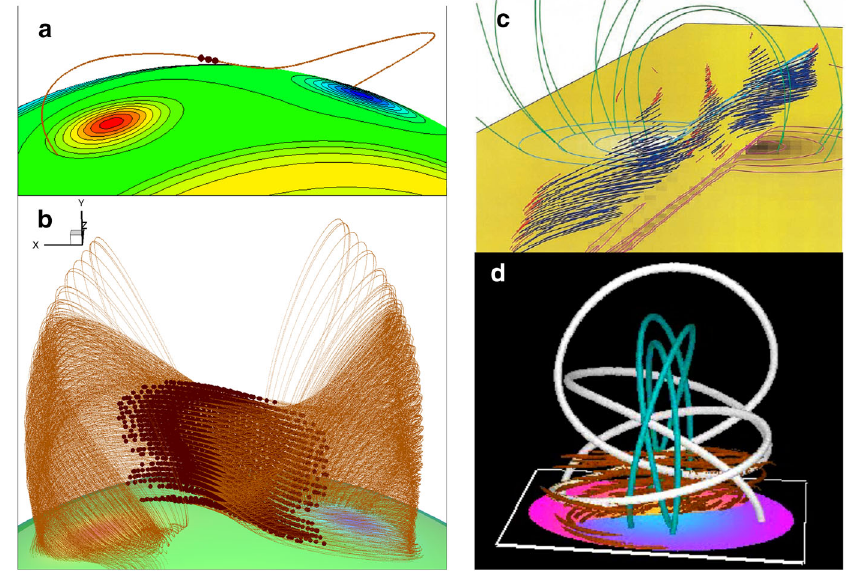
Fig.6 “Paintingthedips”ofamagneticskeletonresultsinsheet-likeprominences,independentofmagnetic topology. a Demonstration of the small region this would represent for a sample, dipped field line within a flux rope field model, and b demonstration for many field lines within the rope (after Gibson and Fan 2006a). c Painted dips within 3D sheared-arcade model. Image reproduced with permission from Aulanier et al. (2002), copyright by AAS. d Painted dips within 3D analytic model of spheromak-type magnetic flux rope. Image reproduced with permission from Lites and Low (1997), copyright by